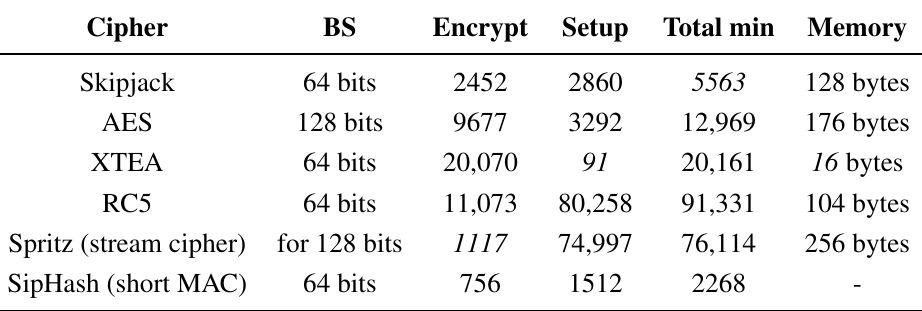
Table 3. Cycles required per operation/block. BS, block